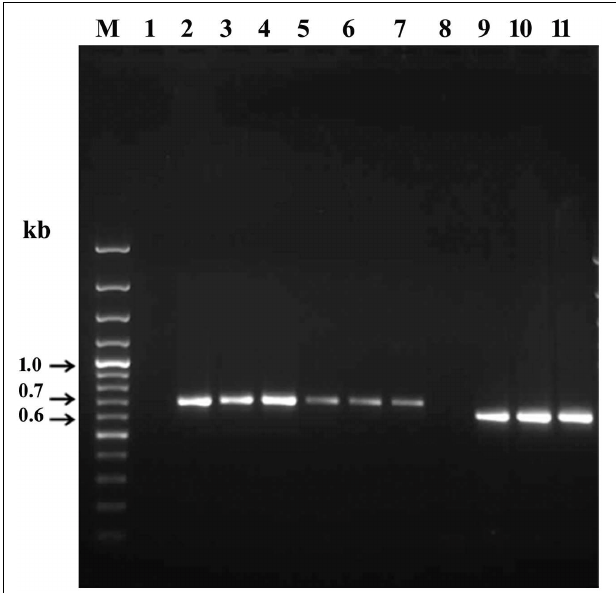
FIGURE 2 | Expression of qnrVC5 and aac(6’) Ib-cr genes in the native V. fluvialis host and in E. coli JM109 transformants derived from the plasmids of native hosts. 100 bp Gene ruler (Fermentas) was used as the marker (M). Lane 1: Negative control (without reverse transcription step) for RT-PCR product of qnrVC5 transcript (657 bp) from V. fluvialis hosts BD146; Lanes 2 to 4: RT-PCR products of qnrVC5 transcript (657 bp) from V. fluvialis hosts BD146, L10734 and L9978, respectively; Lanes 5 to 7: RT-PCR products of qnrVC5 transcript (657 bp) from transformants of BD146 (7.5 kb + ), L10734 and L9978; Lane 8: Negative control (without reverse transcription step) for RT-PCR product of aac(6’) Ib-cr transcript (657 bp) from